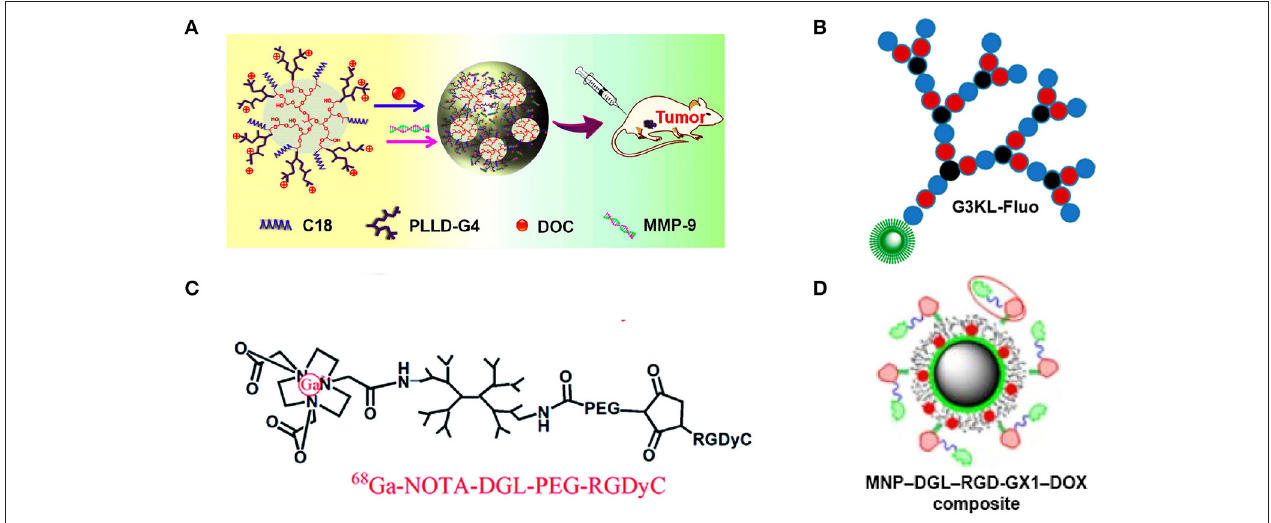
FIGURE 3 | Illustrations to modification of lysine-based dendrimers: (A) Interior block [PLLD-G4, (Zhou et al., 2016)]; (B) Incorporation [G3KL-Fluo, (Gan et al., 2019)]; (C) Exterior modification [ 68 Ga-NOVA-DGL-PEG-RGDyC, ( Fang et al., 2020)]; (D) Combination [DGL-coated MNP, (Shen et al., 2017)].